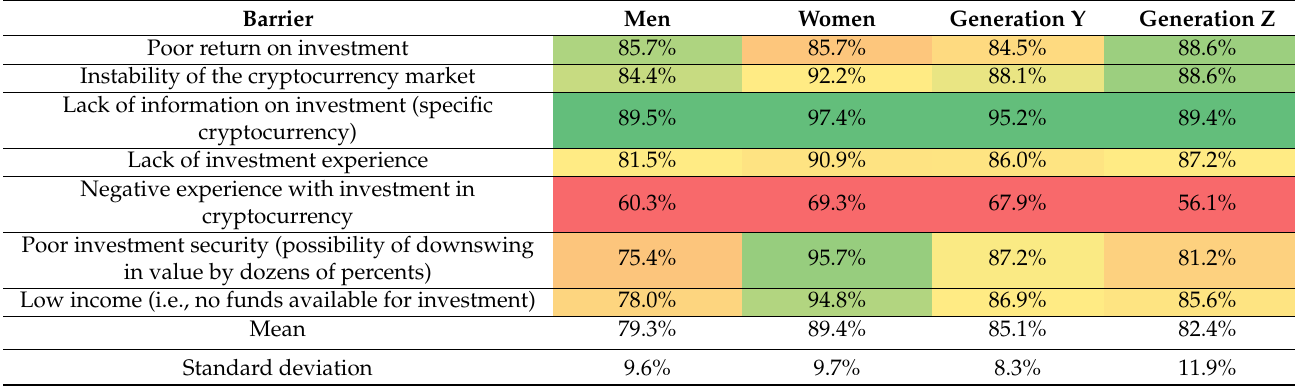
Table 4. Percentage of respondents discouraged from investment in cryptocurrency by the given barrier. The table includes respondents having and not having a tendency to take risks. The respondents are divided into the following categories: men, women, Generation Y, and Generation Z, and a green-yellow-red scale is selected for the entire